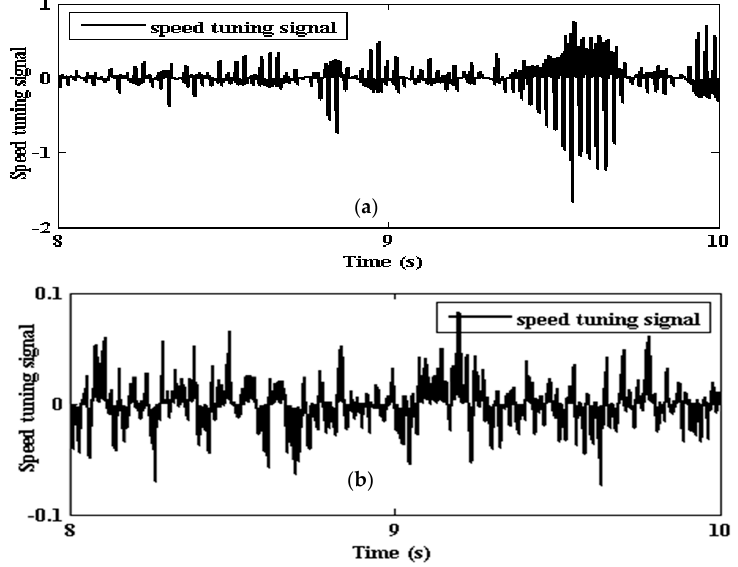
Figure 21. Speed tuning signal for nominal setting of stator resistance (R s ) and rotor time constant (T r ) for ( a ) SMLO 1; and ( b ) SMLO 2.